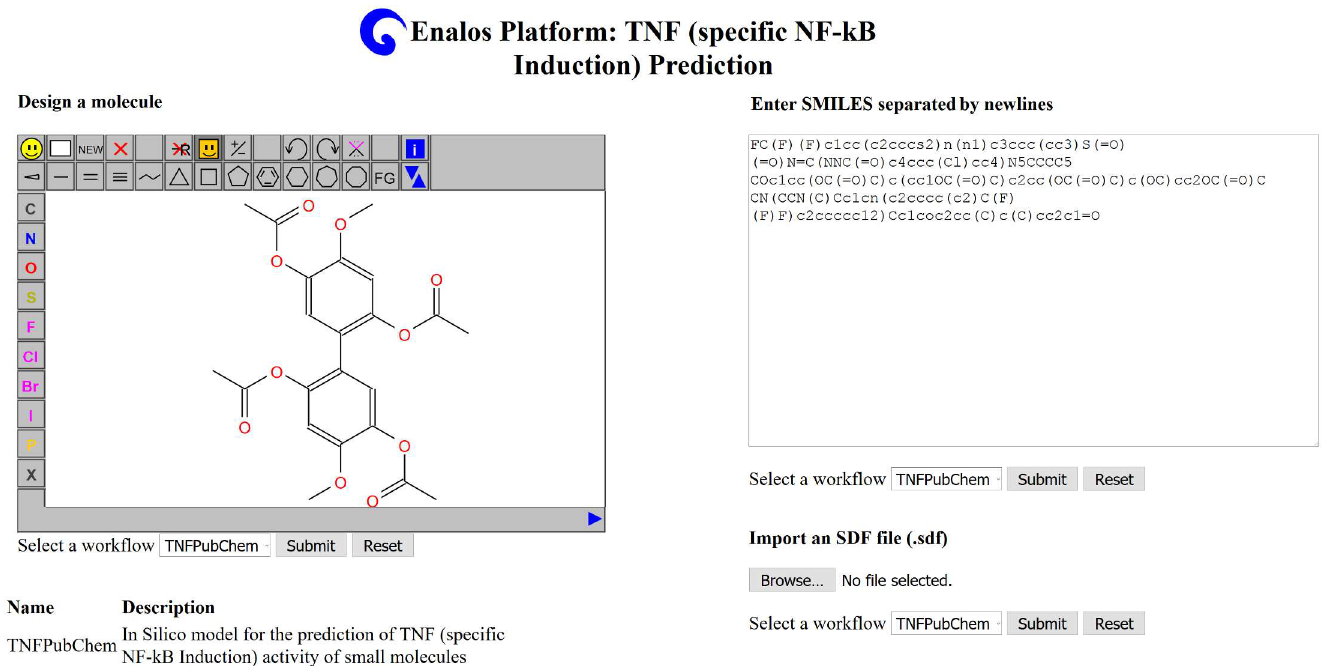
Fig 3. The sketching and structural modification facility for the prediction of new TNF inhibitors as provided by the Enalos cloud platform (screenshot).